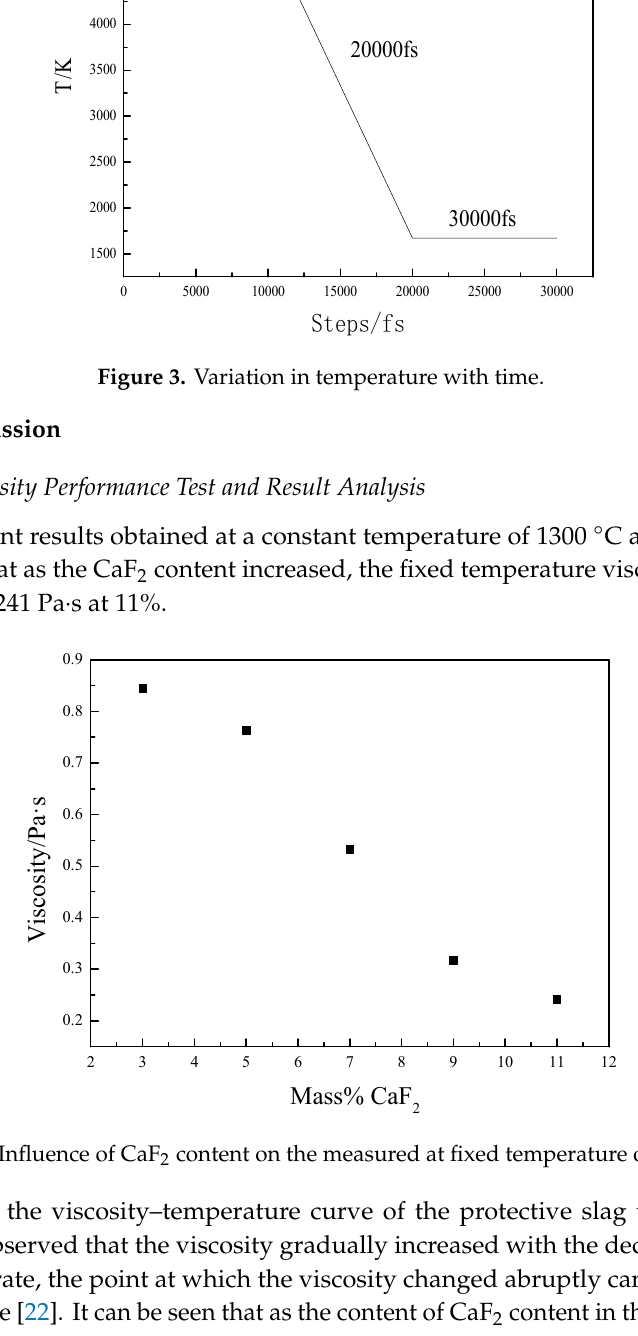
Figure 4. Influence of CaF 2 content on the measured at fixed temperature of 1300 °C.